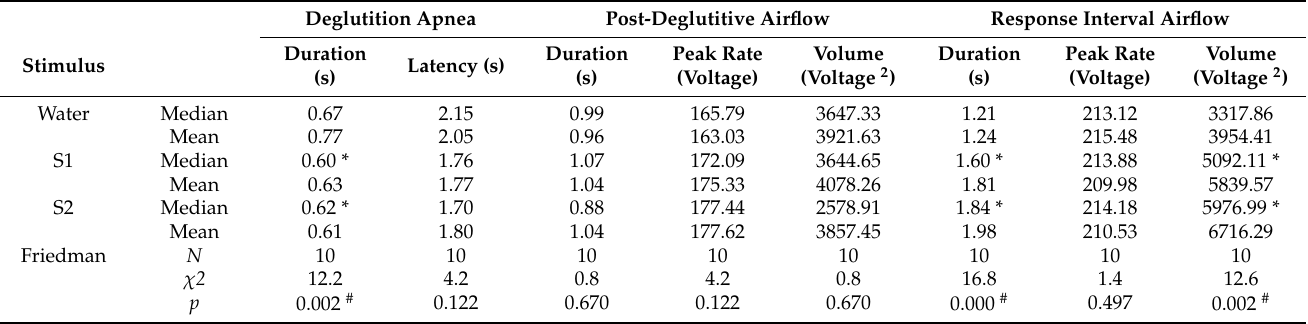
Table 1. Comparison of deglutition measures and retronasal airflow measures across oral fluid conditions. Air pressure voltage traces were extracted for the first period of deglutition apnea and the first retronasal post-deglutitive air pulse in each correct trial, as well as for the response interval between fluid contact and the behavioral response. Peak rate was calculated as the maximum voltage value during each interval, and airflow volume was calculated as the area above the session-wide mode (no airflow). Voltage is represented in arbitrary units of magnitude. # Denotes significant main effect of fluid condition (Friedman test, p < 0.05). * Denotes significant difference from water stimulus condition (Wilcoxon signed-rank test, p < 0.0167). No post hoc comparisons conducted between S1 and S2 conditions were statistically